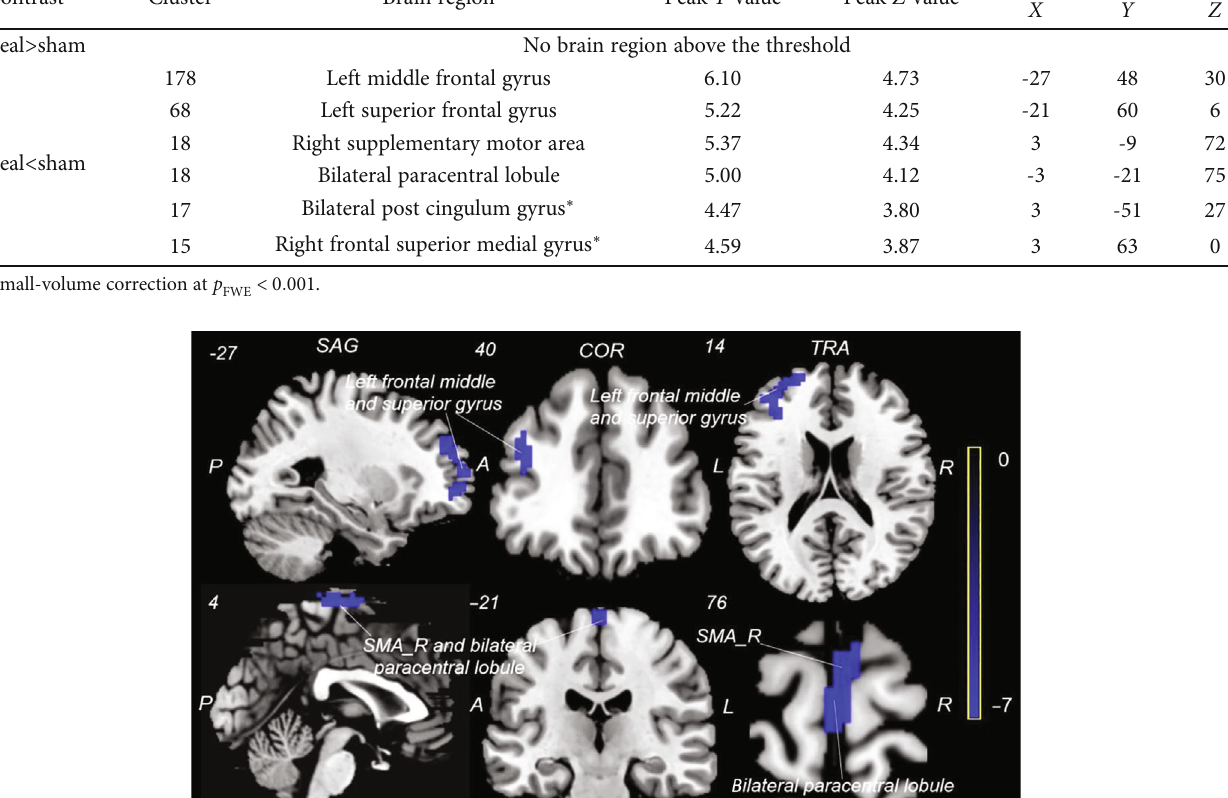
MNI coordinates X Y